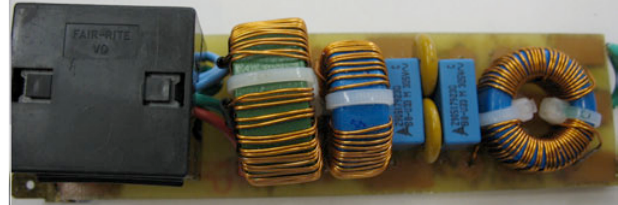
Figure 9: Measured impedance Zp without EMI filter.